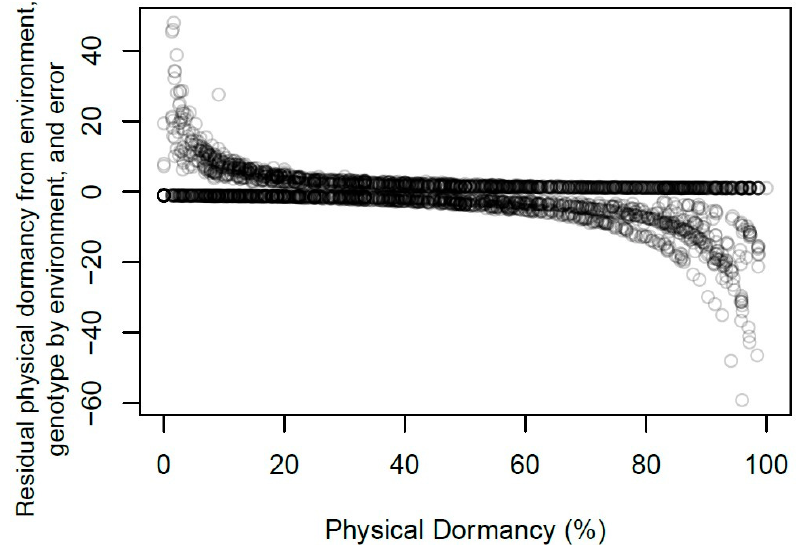
Figure 2. Relationship between percent physical dormancy and residuals, including environment, genotype by environment, and error. Residuals indicate the deviance in log-likelihood of physical dormancy from genetic and technical replicate effects. Negative residuals indicate observations with high physical dormancy relative to genetic and technical replicate effects. Positive residuals indicate observations with low physical dormancy relative to genetic and technical replicate effects.